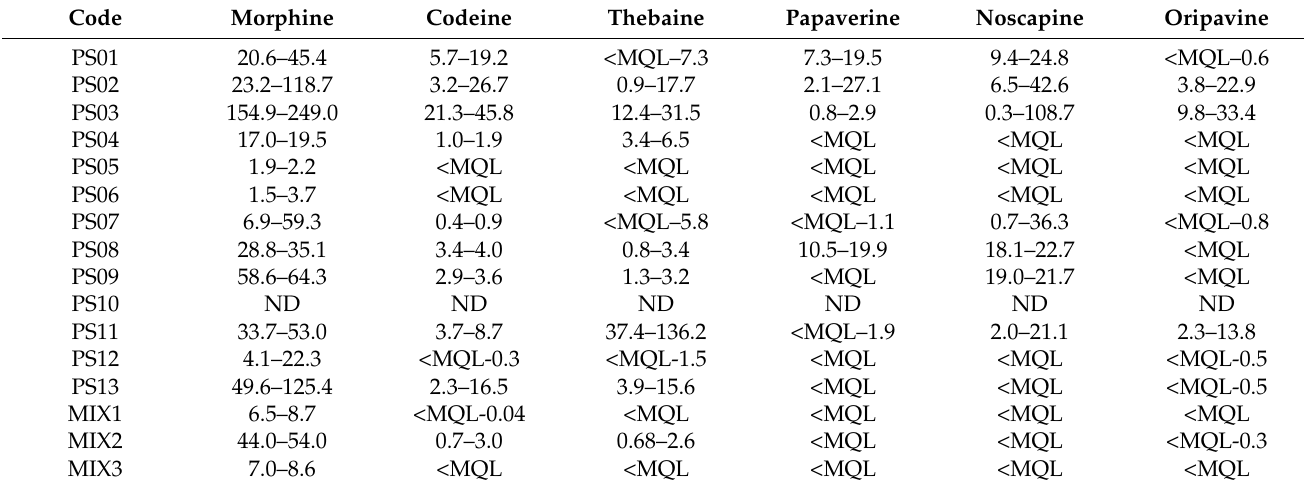
Table 4. Range of occurrence (mg/kg) of each of the six opium alkaloids analysed in three samples ( n =